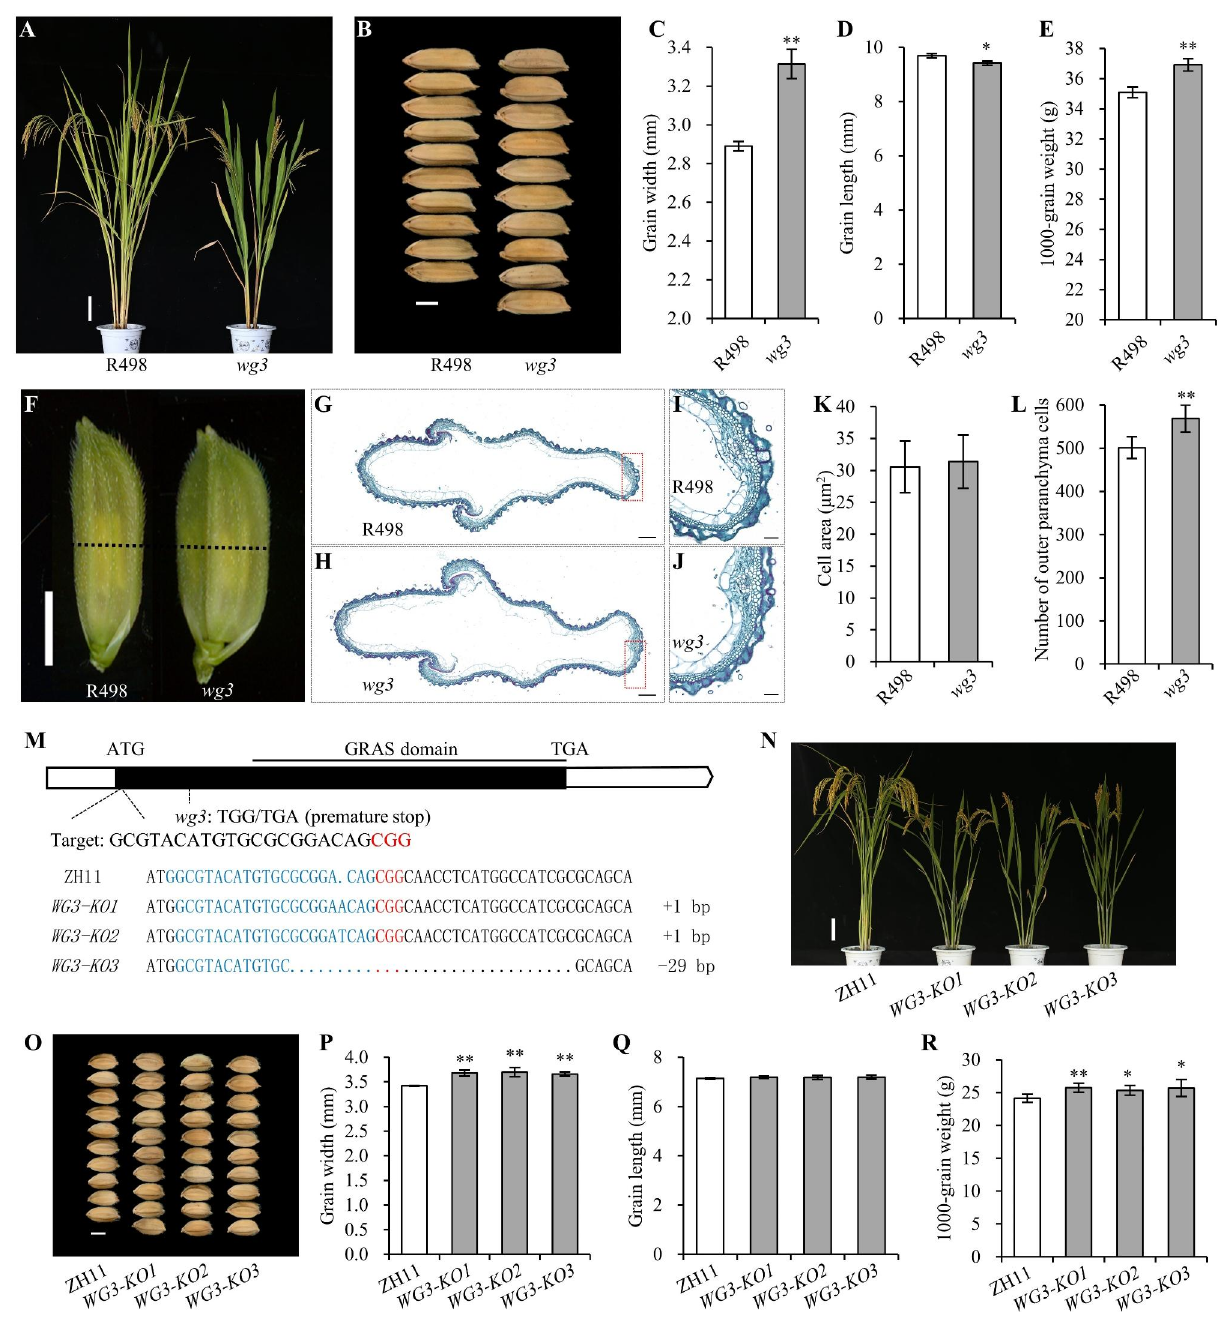
Fig. 1 WG3 regulates grain width by affecting cell proliferation in rice. (A) Plant architecture of R498 and wg3 at the mature stage. Scale bar, 10 cm. (B) Comparison of grain width between R498 and wg3 . Scale bar, 3 mm. (C-E) Statistical analysis of grain width (C), grain length (D), and 1000-grain weight (E) between R498 and wg3 . (F) Spikelet hulls of R498 and wg3 before flowering. Scale bar, 3 mm. (G, H) Cross-sections of the spikelet hulls of R498 and wg3 . The position of the cross-section is indicated by a black dotted line in F. Scale bars, 200 μm. (I-J) Magnified views of the cross-section boxes in G and H. Scale bars, 50 μm. (K, L) Comparison of cell area (K) and cell number (L) in the outer parenchyma layer. (M) Schematic diagram of the WG3 gene, and alignment of WG3 sequences between ZH11 and WG3 - KO mutants. The GRAS domain, knockout target site, and the mutation site in wg3 are shown. The PAM sequences are highlighted in red and the target sequences are highlighted in blue. (N) Plant architecture of ZH11 and WG3 - KO mutants at the ma- ture stage. Scale bar, 10 cm. (O) Comparison of grain width between ZH11 and WG3 - KO mutants. Scale bar, 3 mm. (P-R) Statistical analysis of grain width (P), grain length (Q), and 1000-grain weight (R) between ZH11 and WG3 - KO mutants. Data are given as means ± SD [ n = 3 replicates, and each replicate contained five plants in (C-E); n = 20 in (K, L); n = 6 plants in (P-R)]. Significant differences between wild type and corresponding mutants (* P < 0.05 and ** P < 0.01) were determined using a Student’s t